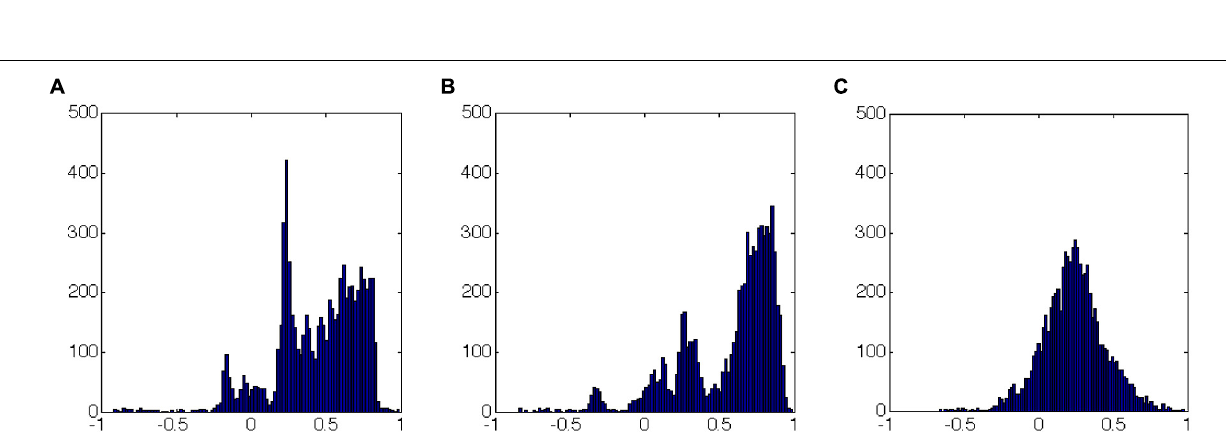
between features (expressing similarity over time of the linked features). These networks show which features are highly correlated during the different recordings, thus topological observables related to these network may provide a generalized representation of the different rearing